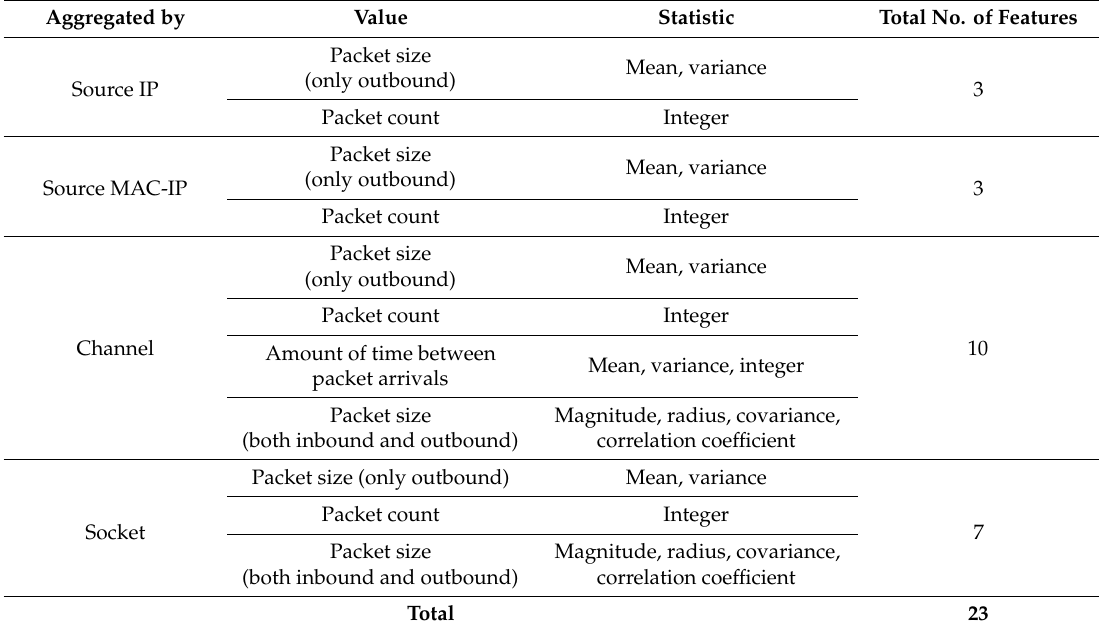
Table 4. Detailed features of the N-BaIoT dataset.